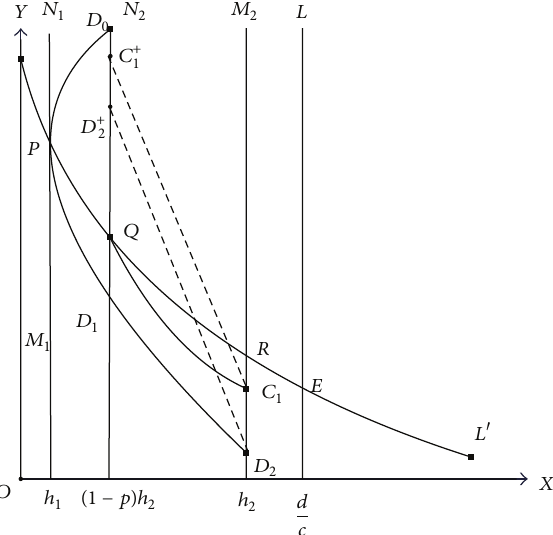
Figure 6: The orbit starting from the point 𝐶 0 (Case 3 in Section 4.1.1).